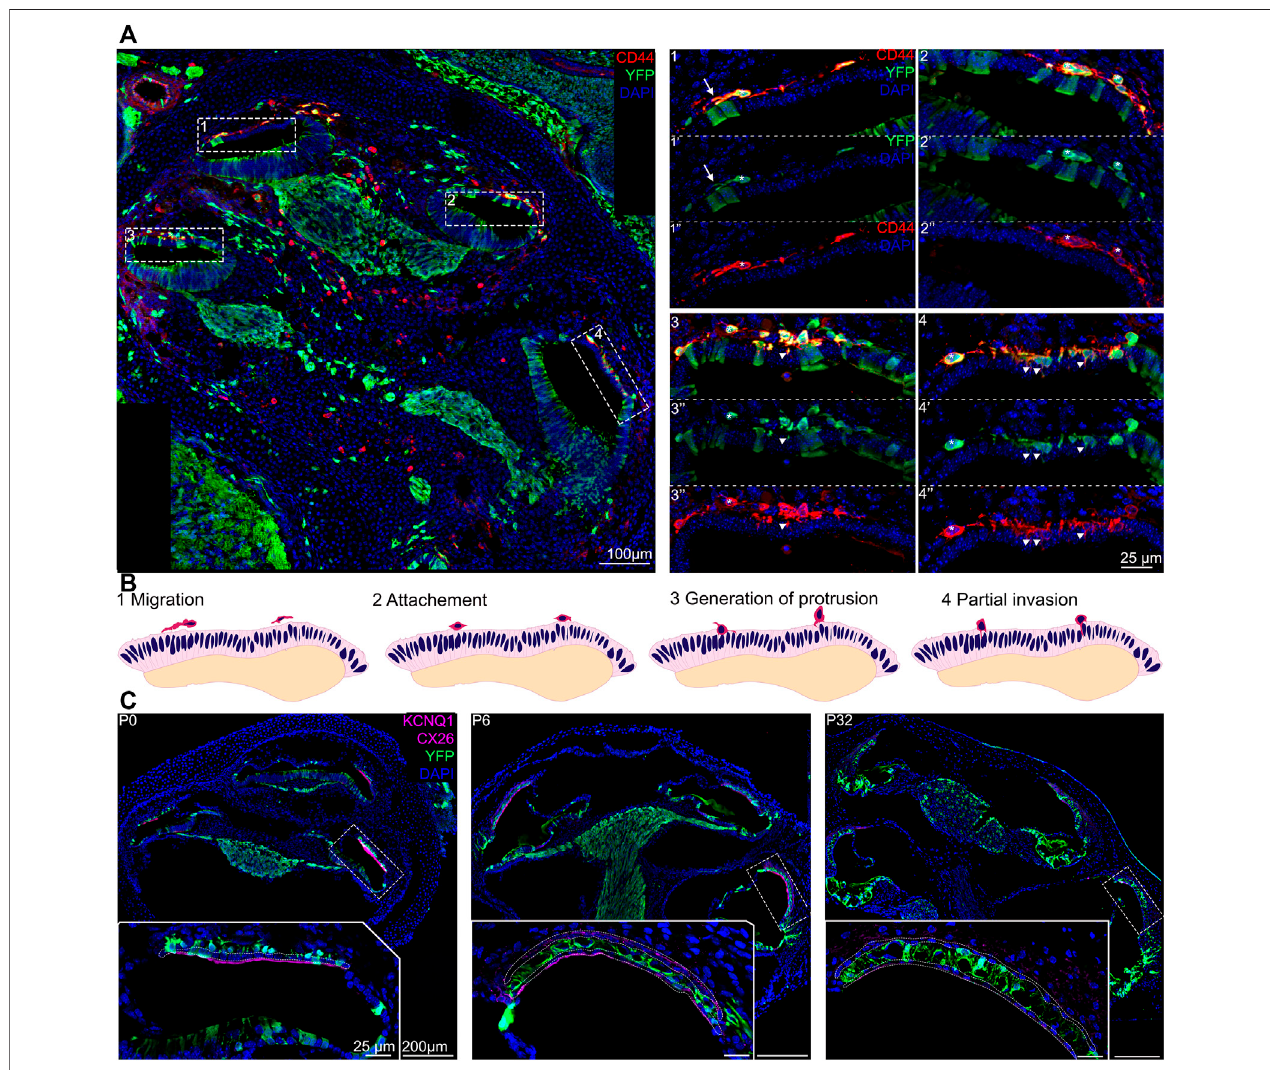
FIGURE 3 | Proliferation in the stria vascularis decreases 2 weeks after birth. (A) Schematic of the experimental using Edu injection at different time points during development. (B) Immunostaining of Wnt1Cre-YFP mice from P0 to P14 with EdU labeling (dark pink) and DAPI, a nuclear marker in blue. Some Edu positive marginal, intermediate and basal cells are shown by arrows, stars and arrowheads respectively. Anti-activated caspase 3 labeling (in turquoise) shows no signi fi cant cell death in thestriavascularisduring development(rightpanel). (C) Graphicoftheaverageproliferationinthethreedifferentlayersoftheinner earfromE16.5toP14.Foreach stage n =